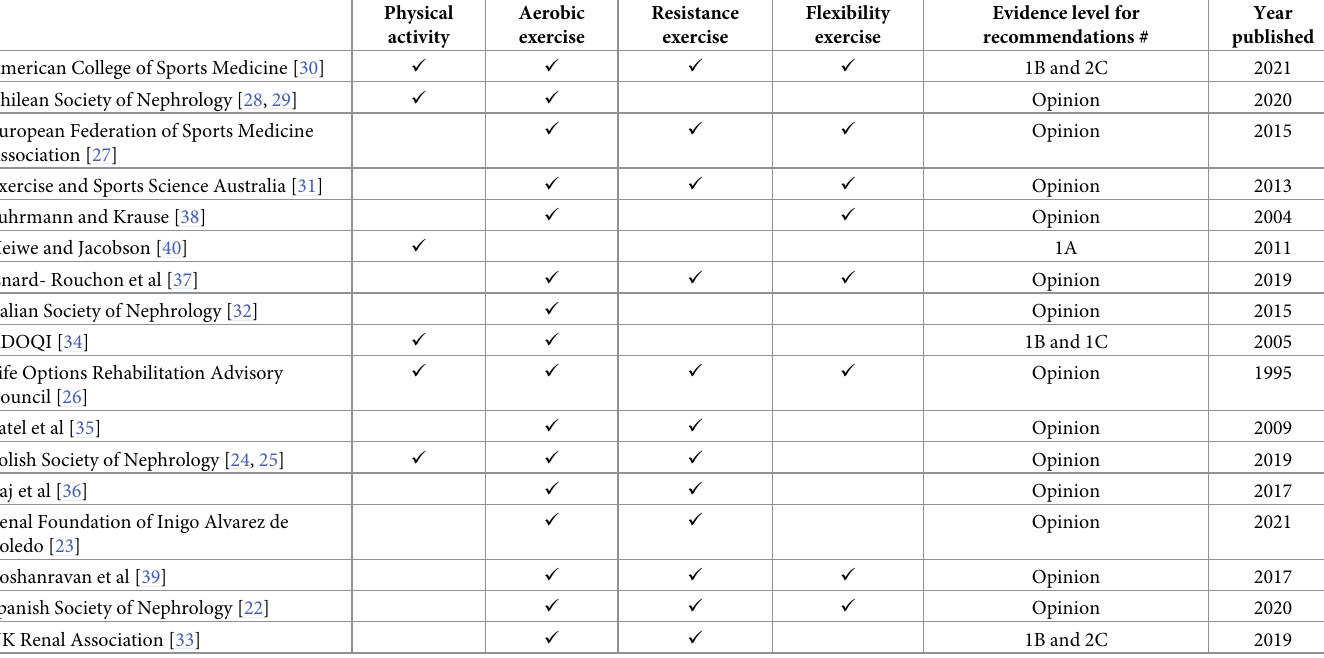
Table 3. Overview of guidance retrieved on physical activity and exercise with a rating of the quality of evidence and the strength of recommendations contained within these publications.